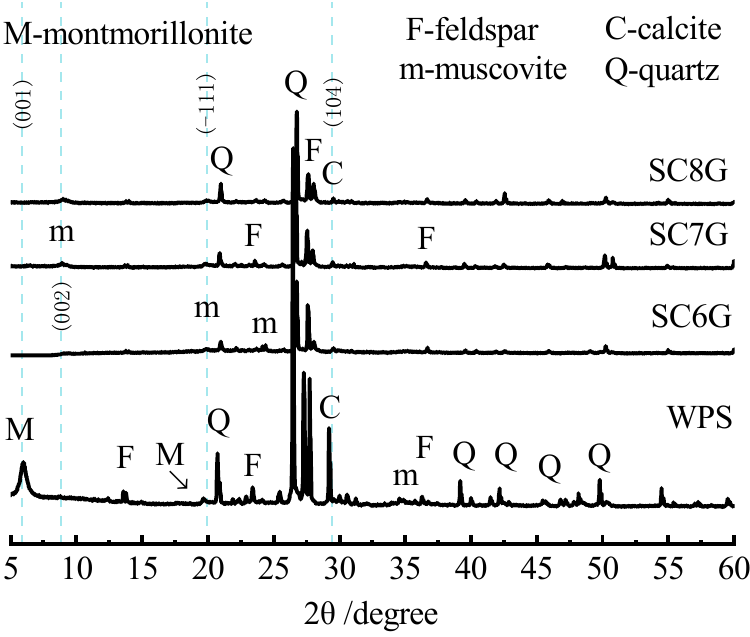
Figure 2. XRD of mechanochemically and thermally activated WPS.